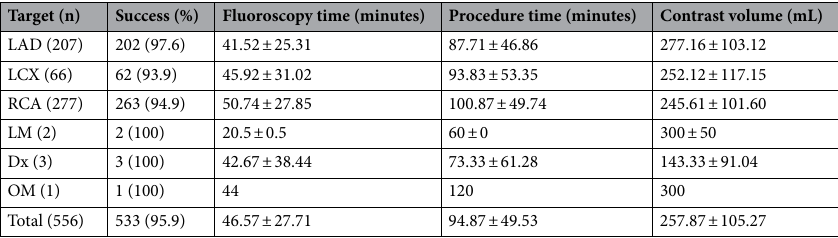
Table 2. Procedure Outcomes and Technical Parameters. LAD left anterior descending artery, LCX left circumflex artery, RCA right coronary artery, LM left main coronary artery, Dx diagonal branch, OM obtuse marginal branch.